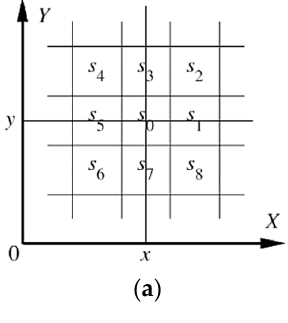
Figure 3. The principle of linear spatial filter: ( a ) original image; ( b ) filter template; ( c ) the filtered result.